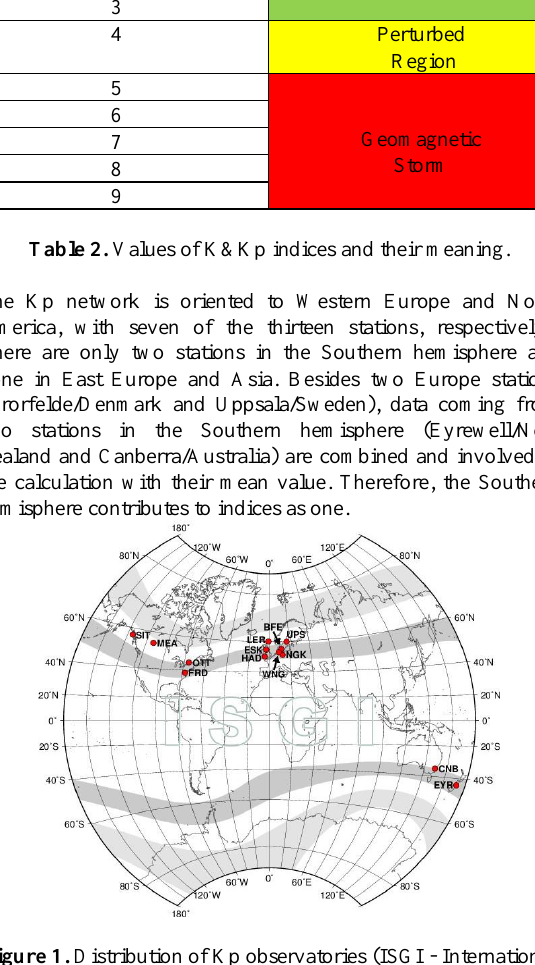
Figure 1. Distribution of Kp observatories (ISGI - International Service of Geomagnetic Indices,